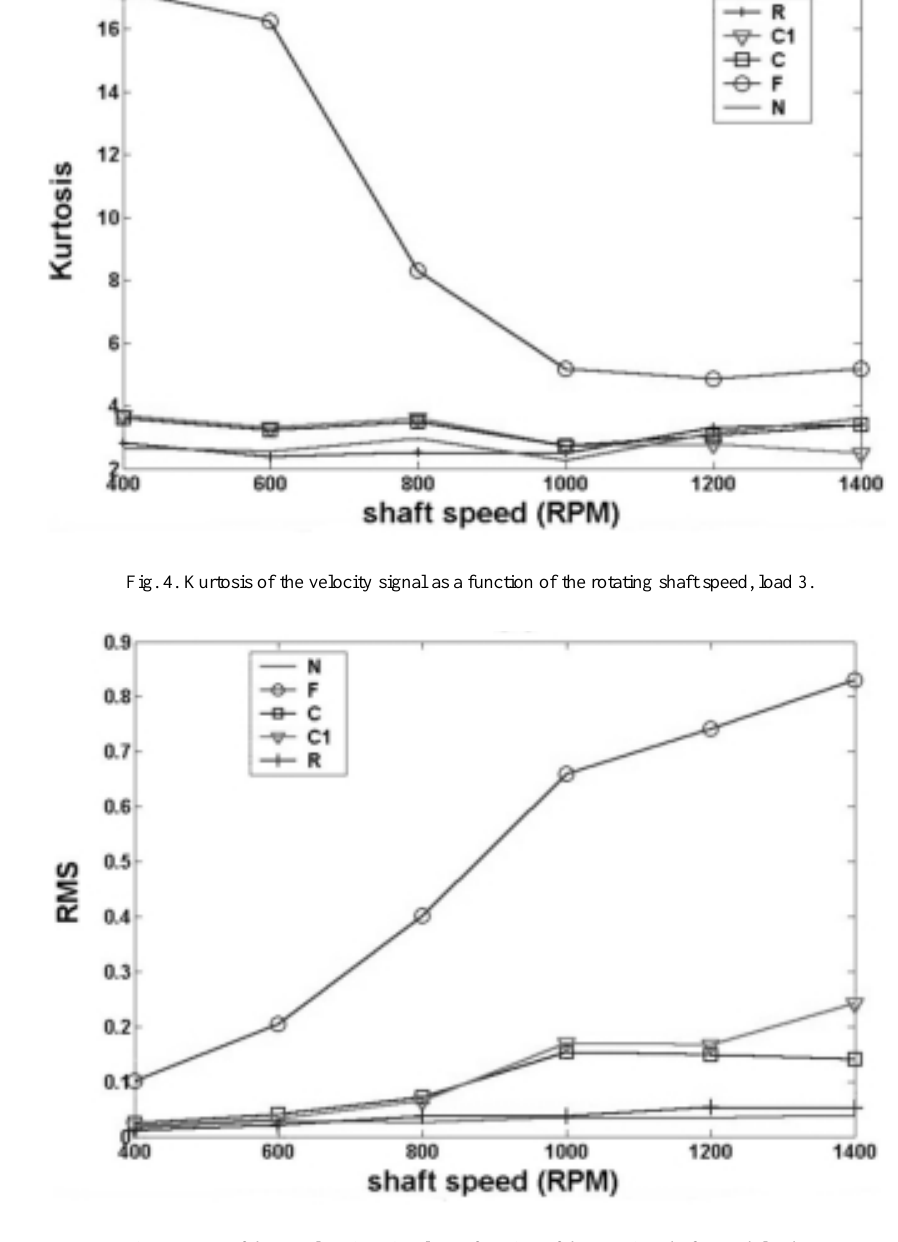
Fig. 5. RMS of the acceleration signal as a function of the rotating shaft speed, load